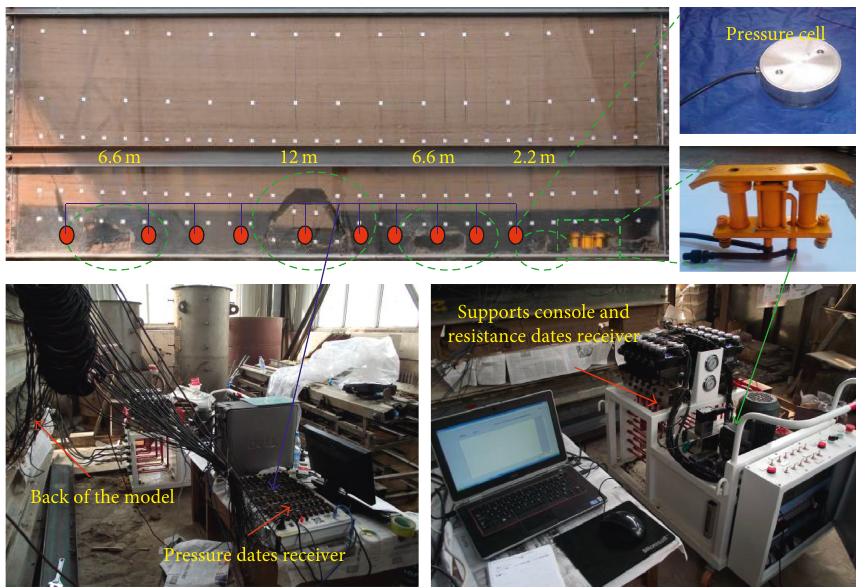
Figure 4: Experiment model and microsupport and real-time monitoring devices.